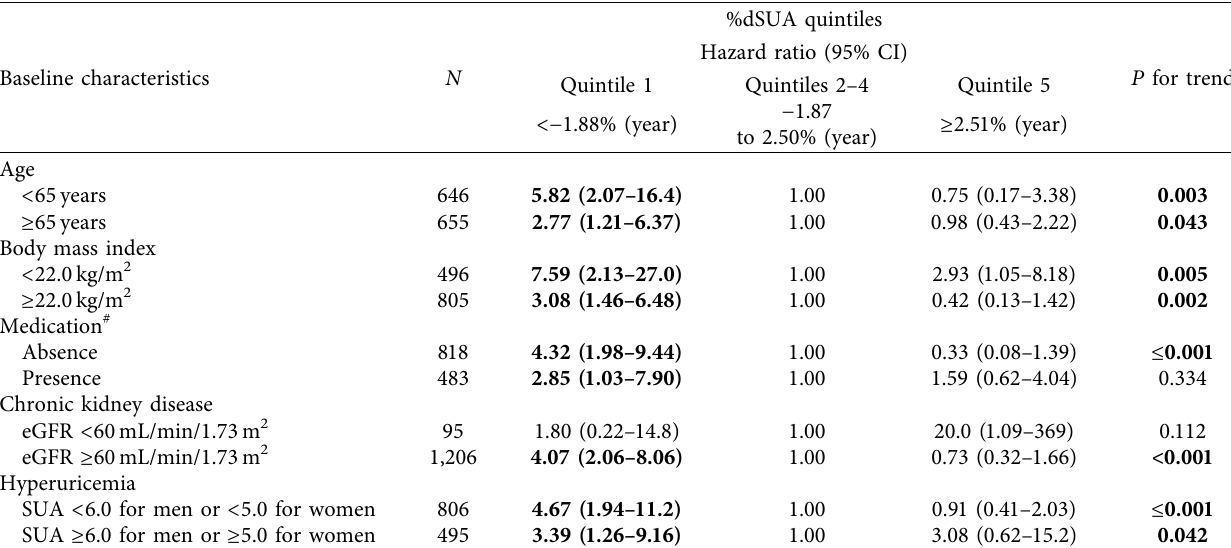
Table 3: Hazard ratios and 95% CIs for all-cause mortality according to %dSUA quintiles by subanalysis.